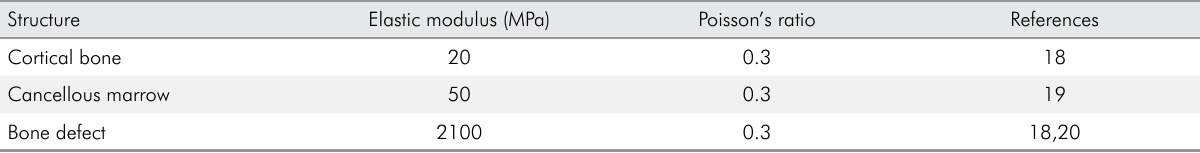
Table 1. Mechanical properties used in the FE